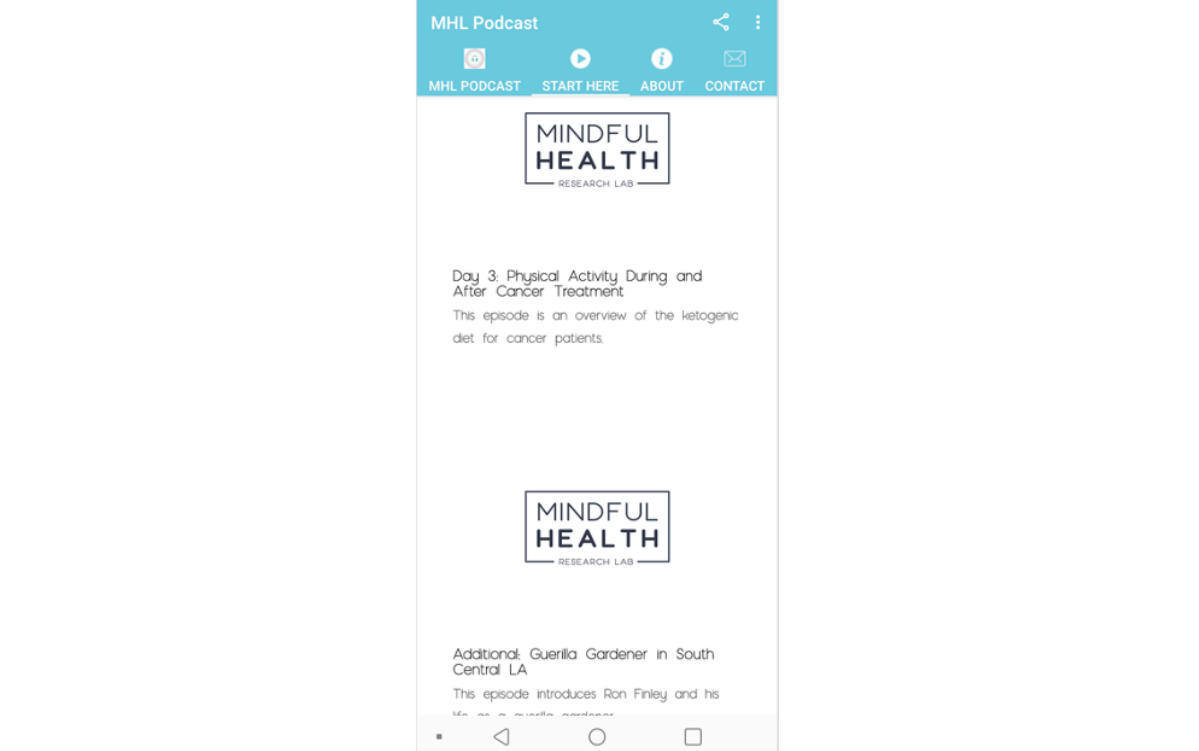
Figure 1. Mindful Health Lab (MHL) podcast app